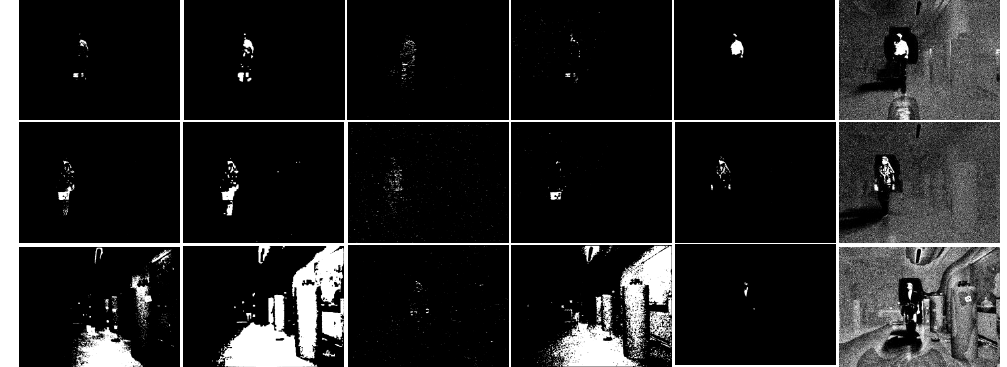
Figure 5. Moving object detection in indoor medium light scene ( Row 1: Object 1, Row 2: Object 2, Row 3 : Object